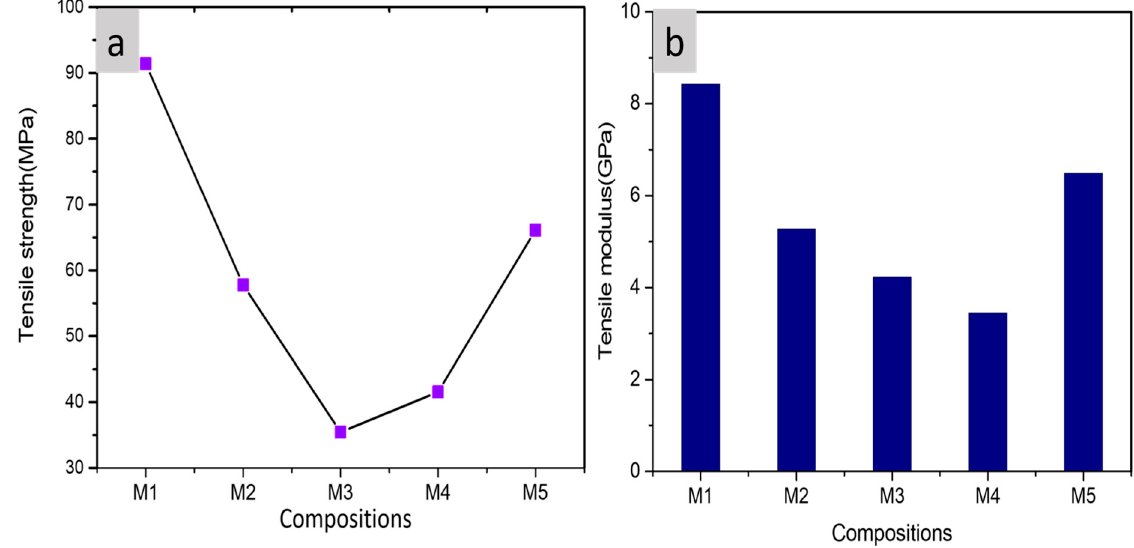
Figure 7. ( a ) Tensile strength (MPa), ( b ) tensile modulus (GPa), of PLA, PLA-PBS, and PLA-PBS-MCC composite films.